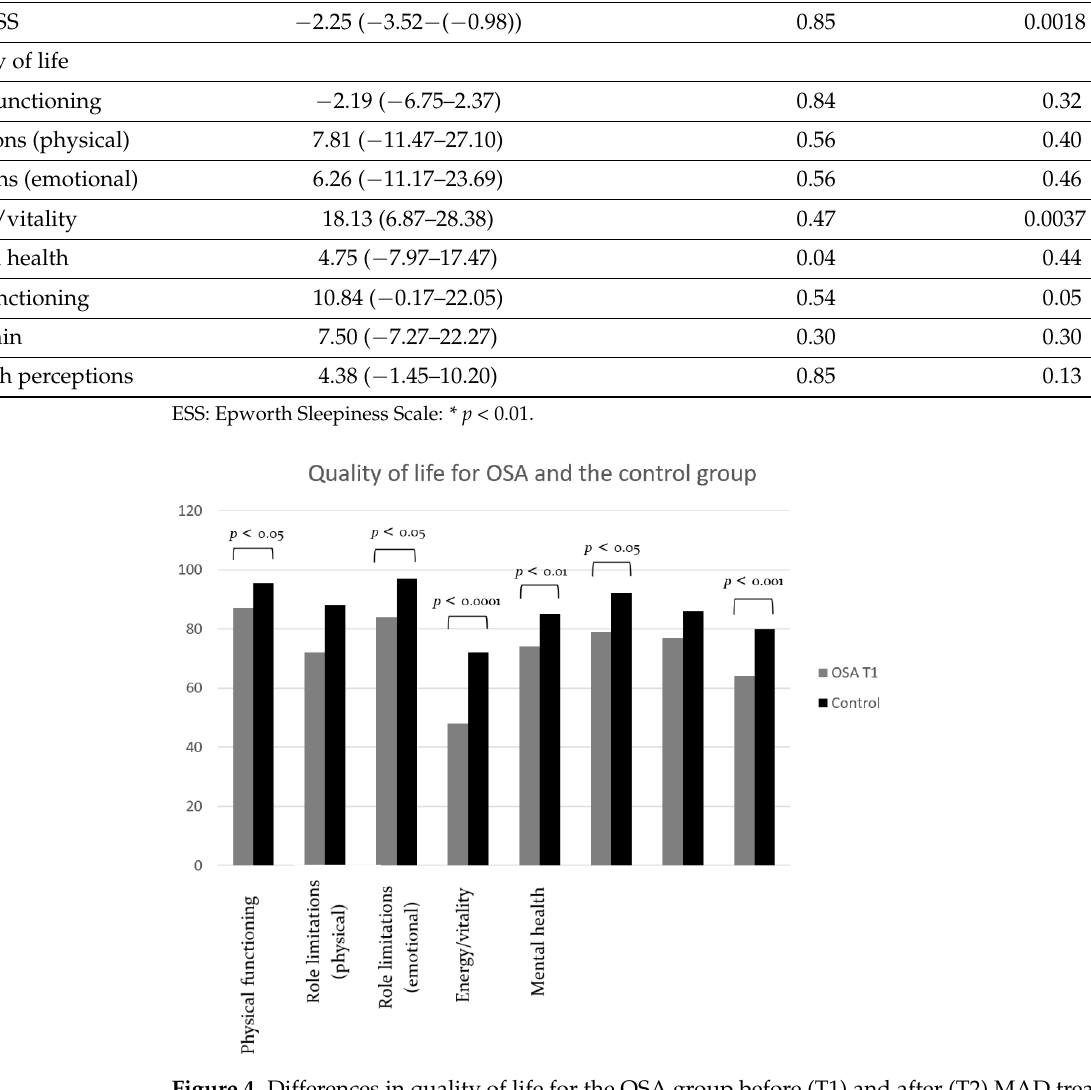
Figure 3. Differences in quality of life between the OSA group and the control group before (T1) Figure 4. Differences in quality of life for the OSA group before (T1) and after (T2) MAD treatment. MAD treatment. Significant differences are shown with lines and p values. Significant differences are shown with lines and p